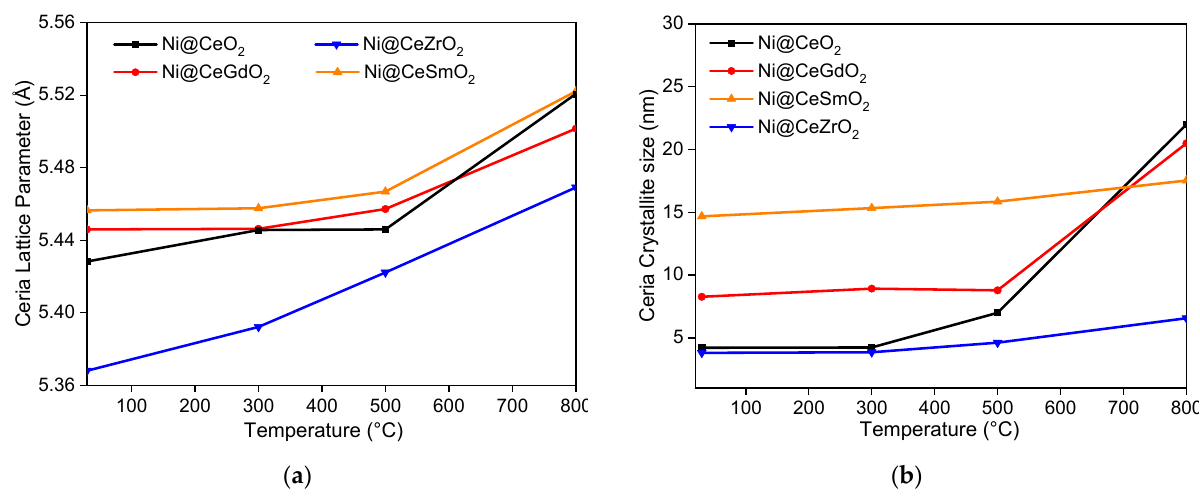
Figure 3. Variation of ( a ) ceria lattice parameter and ( b ) ceria crystallite size during reduction process. Ni crystallite size was not calculated from the in situ diffractograms because the main characteristic line of metallic Ni is overlapped by Khantal line at 2 θ = 44.5°, and the (200) plane of Ni 0 is characterized by a low intensity peak. Therefore, the Ni crystallite size was calculated by XRD after ex-situ reduction of the catalysts at 800 ◦ C followed by passivation. The results are reported in Table 2. The Ni crystallite size is approximately the same for Ni@CeO 2 , Ni@CeGdO 2 , and Ni@CeSmO 2 (between 9.5 and 11.0 nm) while it is smaller for Zr-doped material (5.4 nm). The high resistance to CeO 2 sintering observed for Ce-doped with Zr catalysts avoids Ni sintering. Table 2. Ni crystallite size calculated for the catalysts reduced at 800 °C followed by passivation and TOF values for the dry reforming of methane at 600 °C.